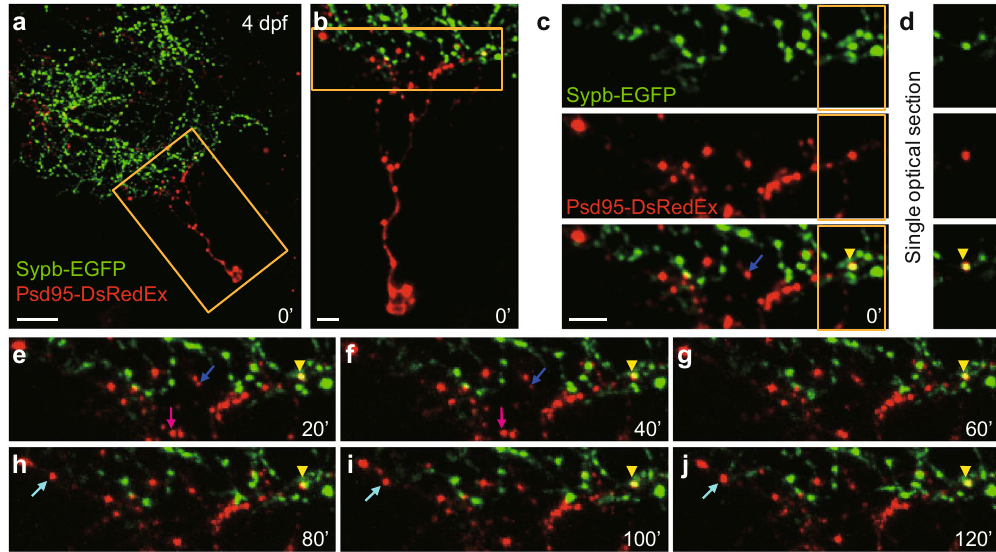
Figure 4. Simultaneous imaging of pre- and post-synaptic compartments of retinotectal synapses. ( a ) First image of a time-lapse series showing the Psd95-DsRedEx labelled post-synaptic sites on the dendritic arbor of a tectal neuron (red) and the Sypb-EGFP labelled pre-synaptic terminals on the axonal arbor of multiple RGCs (green) in a 4-dpf PGUSG larva with transient expression of elavl3:psd95-DsRedEx . The nasal is upwards. Scale bar, 20 μ m. ( b ) Enlarged view of the boxed region in. ( a ) Scale bar, 5 μ m. ( c ) Enlarged view of the boxed region in ( b ) showing single-channel images and the composite image. The yellow arrowhead (bottom) indicates the association of a pre-synaptic terminal labelled by Sypb-EGFP (green, top) with a post-synaptic site labelled by Psd95-DsRedEx (red, middle). ( d ) Single optical section of the boxed region in ( c ) showing the fluorescence overlap of the pre- and post-synaptic punctum. ( c , e–j ) 2-h time series with a 20-min interval showing the overlap of pre- and post-synaptic labels (yellow arrowheads) is stably maintained. Time in minutes is indicated at the bottom right corner of each panel. Postsynaptic Psd95-DsRedEx puncta also showed dynamic behaviours: elimination (blue arrow), transient (magenta arrow), and formation (cyan arrow). Scale bar, 5 μ